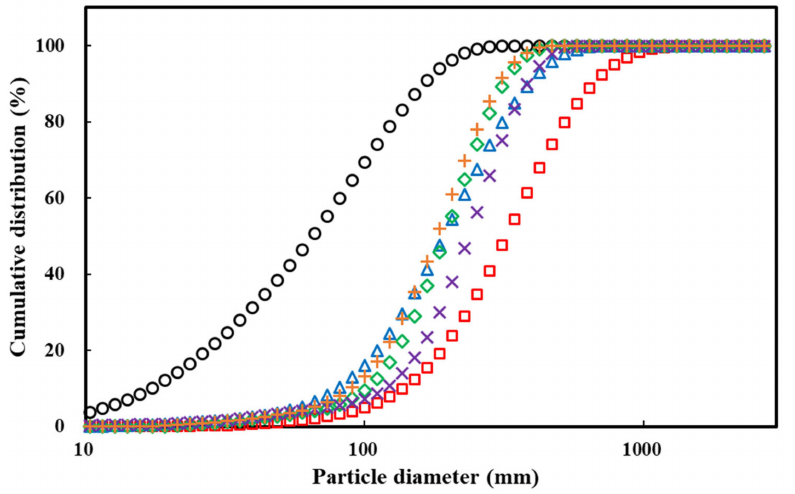
Figure 1. Cumulative distribution of raw and agglomerated PPSPs with different concentrations of MD binder: (